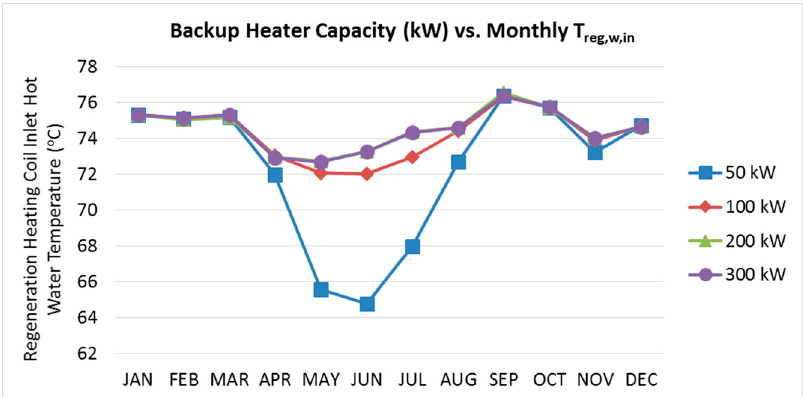
Figure 13. The impact of backup heater capacity on T reg , w , in